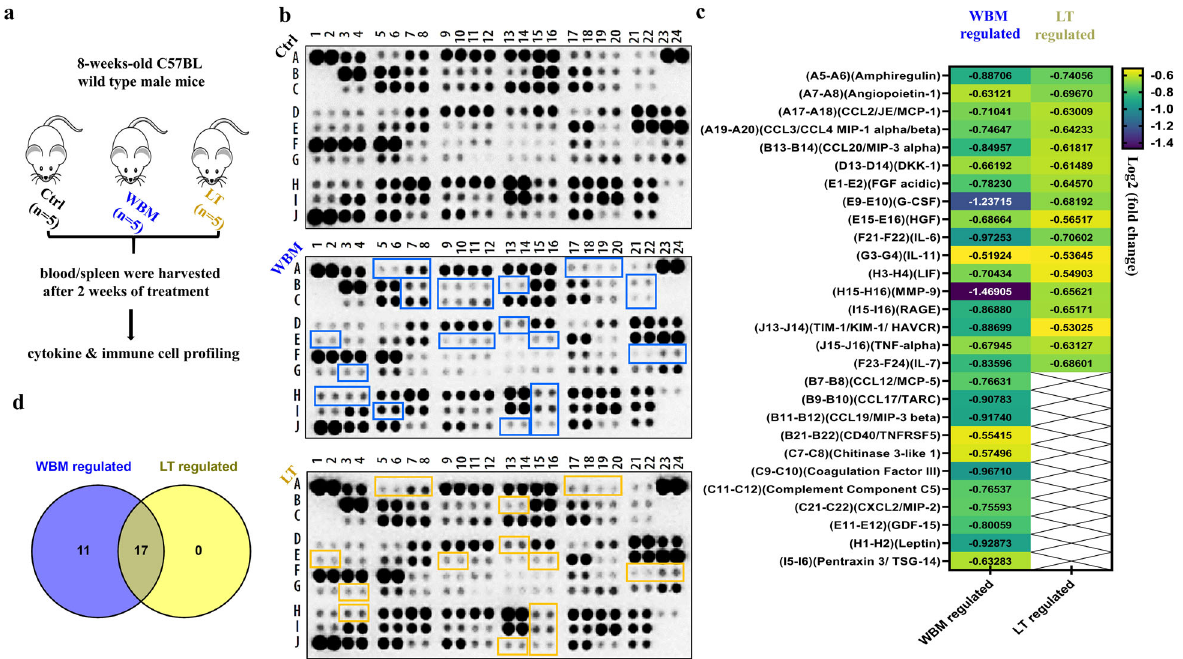
Fig. 4 WBM attenuates pro-in fl ammatory cytokines in mouse serum. a Fifteen intact C57BL/6 mice were randomly divided into 3 groups and treated daily for 2 weeks as follows: mice in the Ctrl group ( n = 5) were gavaged with 100 μ L PBS, mice in the LT group ( n = 5) were gavaged with 6 mg Lentinan, and mice in the WBM group ( n = 5) were gavaged with 6 mg WBM. Serum was collected from each mouse. For the mice in the same treatment groups, their serums were pooled for a total of 500 μ L (100 μ L serum/mouse). Therefore, there was one pooled serum sample corresponding to each treatment group (Ctrl, WBM-treated, and LT-treated). b Proteome Pro fi ler Mouse XL Cytokine Array Kit was used to semi-quantify 111 mouse cytokines, chemokine growth factors, and other soluble proteins in the pooled serum from each group. The image of dot spots represents the changing levels of cytokines. WBM-regulated cytokines were labeled with a purple-blue color, while LT- regulated cytokines were labeled with a light yellow color. c The Quick Spots software was applied to measure the mean spot pixel density, and signi fi cant changes (treatments versus control) were de fi ned as upregulated (log2 fold change ≥ 0.5, p < 0.05) versus downregulated (log2 fold change ≤ 0.5, p < 0.05). d The overlapping cytokines between WBM versus LT treatment were displayed by Venn diagram using Venny